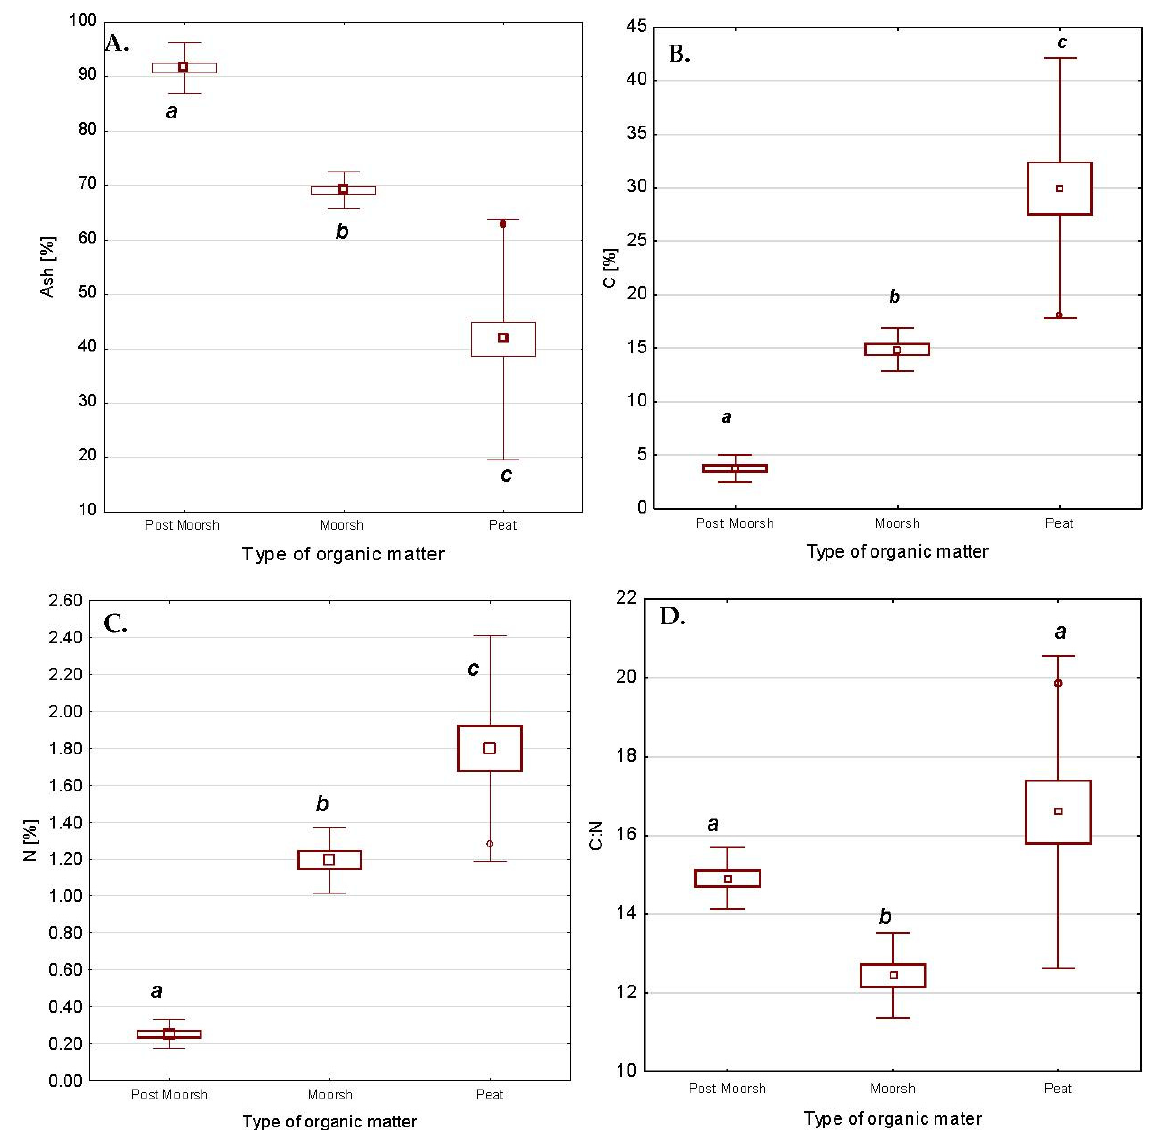
Figure 3. Variability range of the Ash, C, N content and C:N ratio in groups of organic horizons categorised by type of organic matter for Post Moorsh (A horizons of P1), Moorsh (M horizons of P2), and Peat (O horizons of P2 and P3). Explanation: central squares—mean values; boxes—mean values ± standard errors whiskers—mean values ± 2*standard deviations; circle—outliers; asterisk—extreme; letters a, b, c—significance of differences (homogeneous groups of means) by RIR Tukey test (at p < 0.05).